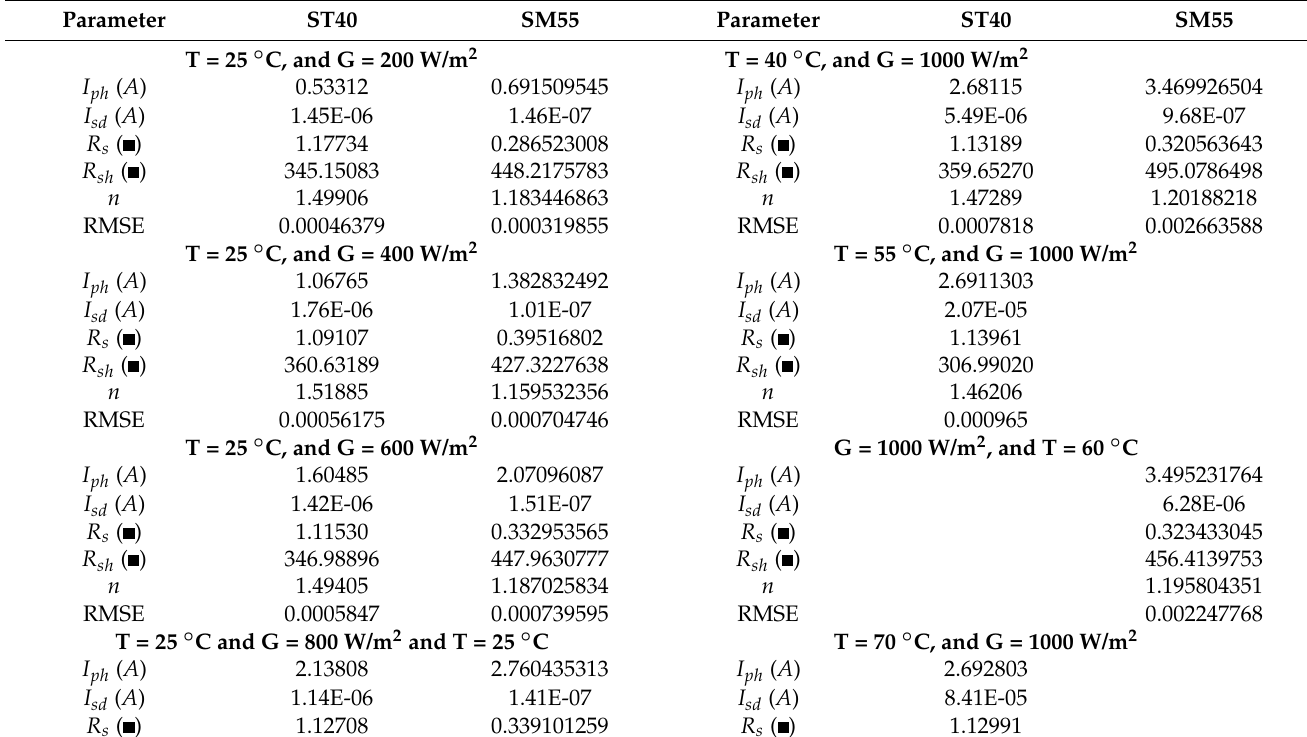
Figure 23. Depiction of the estimated and measured data obtained by MJSO on SM55 under different G with T = 25 °C.